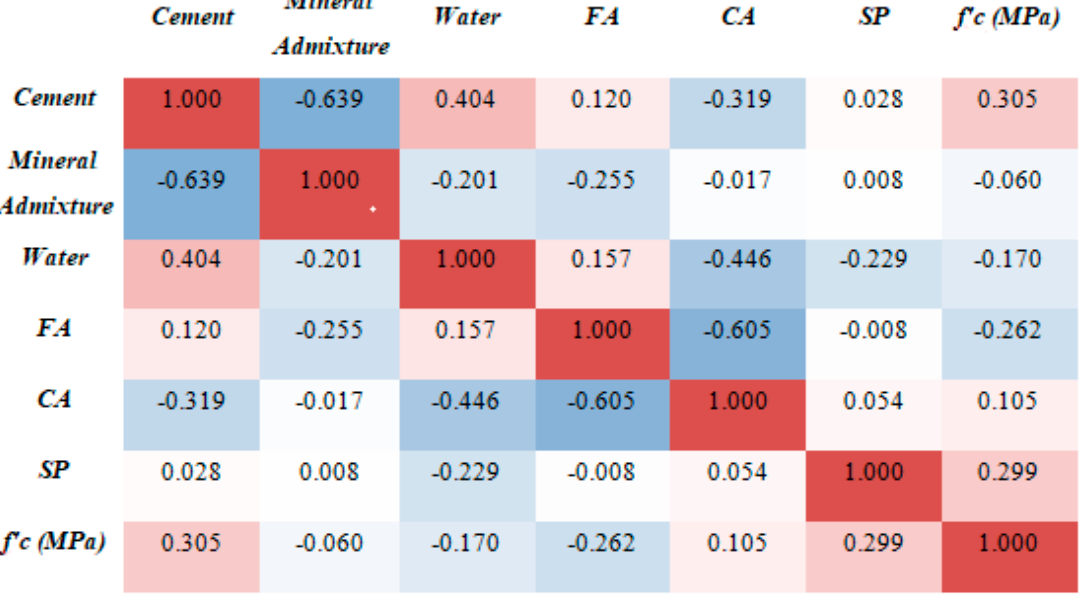
Figure 5. General Structure of the ANN.